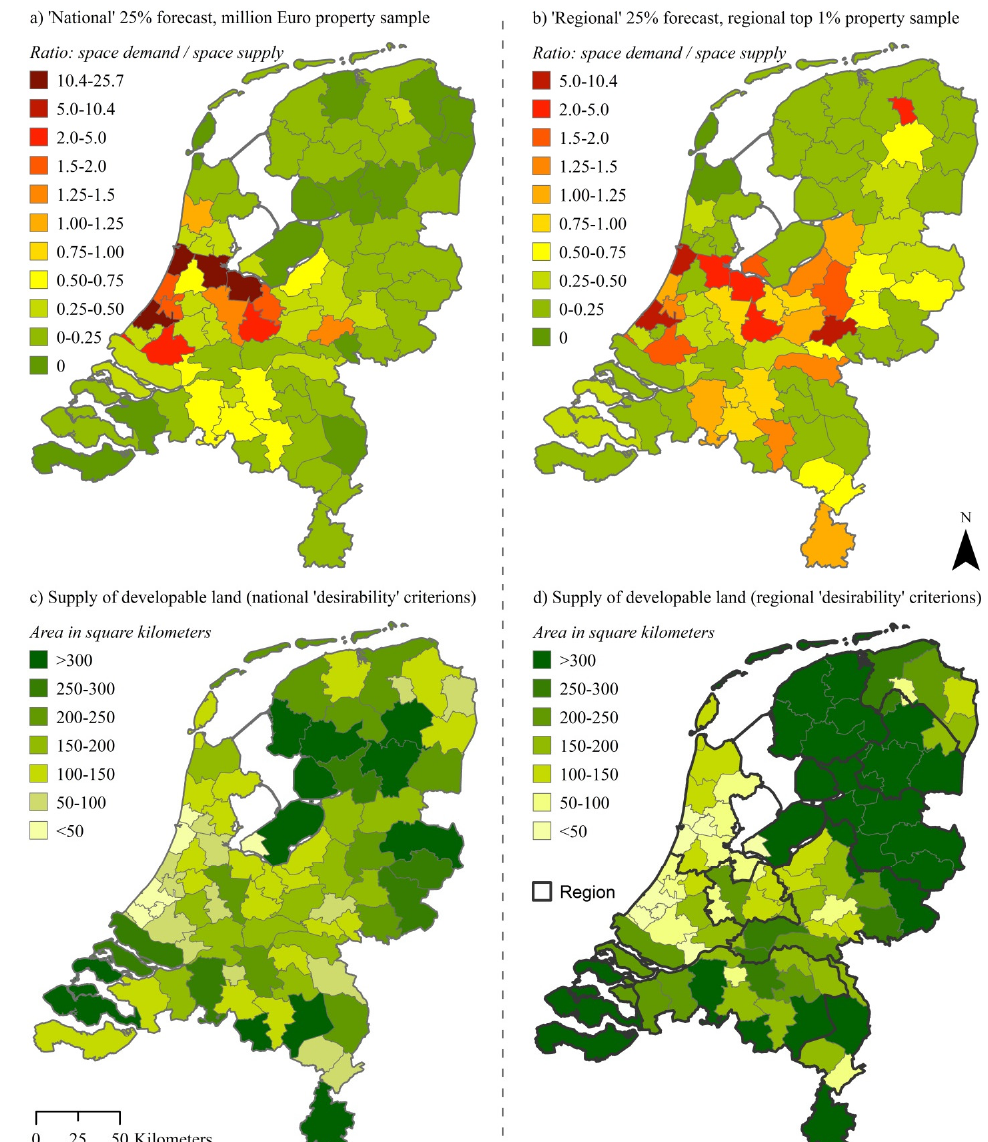
Figure 4. Two forecasts ( a , b ) on how future demand for parcel space and the supply of agricultural land at desirable locations in ( c , d ) relate. The premise is that 25% of the total Dutch population would start to live like the present ‐ day rich, and do so while being distributed across local property markets in proportion to the present ‐ day rich.